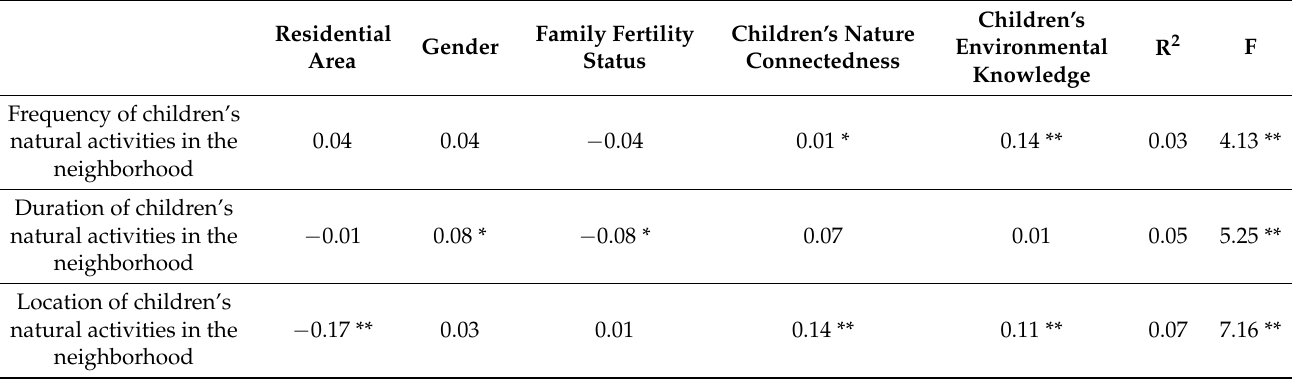
Table 3. Standardized regression coefficients for factors to predict three children’s natural activity parameters and the fitness of the model R 2 and